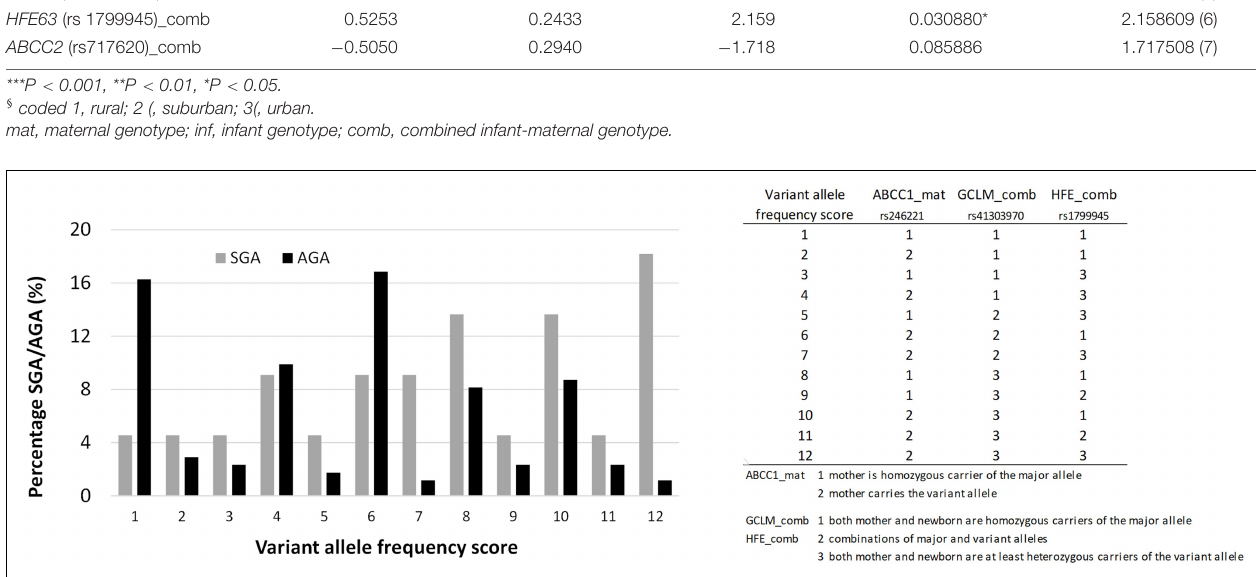
depend on ABCG2 in a human placental perfusion model (Kummu et al.,